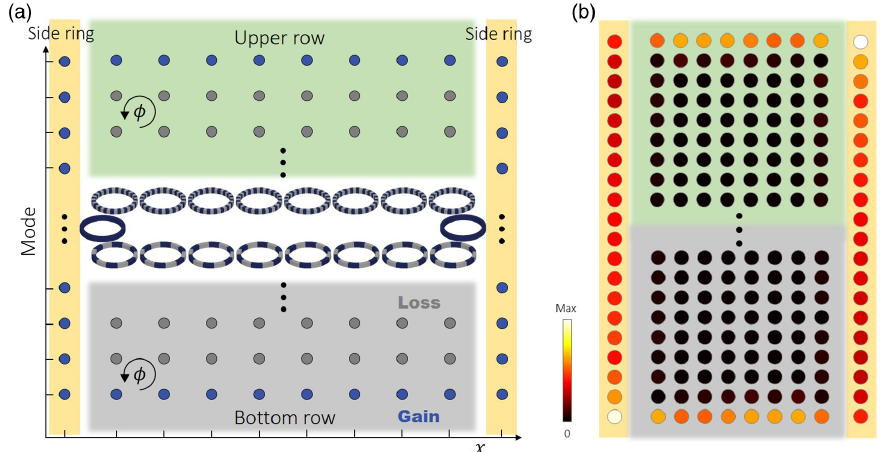
FIG. 1. Schematic of one module of the topological insulator laser in synthetic dimensions. (a) The photonic array consists of modulated rings, in the form of two independent rows connected by two side resonators. The blue and white staggered pattern indicates the different pumping schemes. The shaded regions show the synthetic space including one spatial and one synthetic mode dimensions. The blue (gray) circles indicate the gain (loss), where the gain is provided only to the upper (lower) mode in the upper (lower) row, and to all modes in the side rings. (b) The typical topological lasing state extending over the artificial perimeter of the 2D synthetic space. The color bar indicates the intensity of light. The unitless parameters for simulation are N ¼ 18 , M ¼ 20 , t 0 ¼ t and γ ¼ 0 . 3 . The topological system has band gap size of 1 . 6 t 0